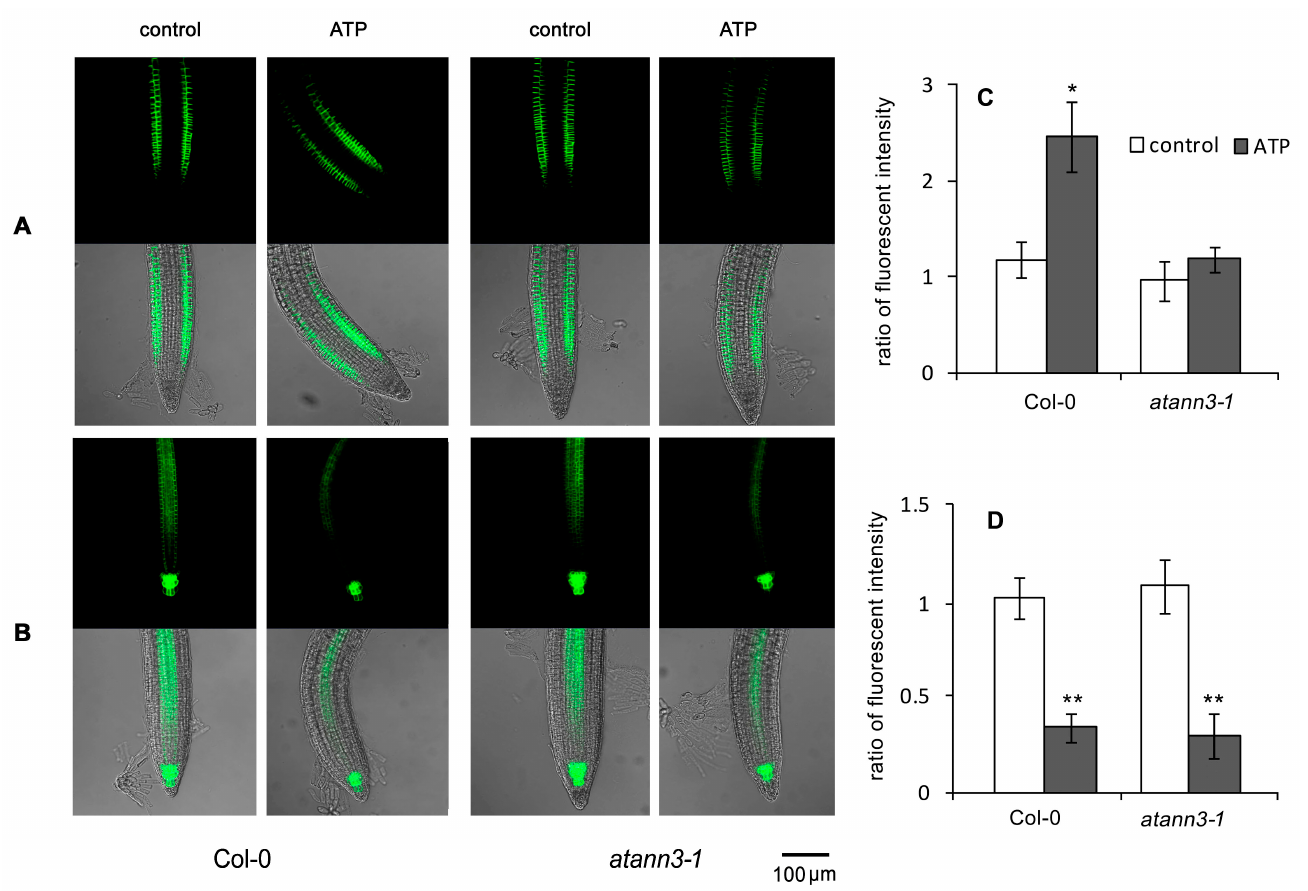
Figure 4. AtANN3 is involved in the eATP-induced PIN2-GFP distribution in root cells. The 4-day-old seedlings of PIN2-GFP or PIN3-GFP transgenic lines were transplanted onto the medium containing 0.5 mM ATP and cultured for 2 more days. ( A , B ) Fluorescent images of PIN2-GFP and PIN3-GFP in root tips, respectively. The scale bar is shown in the lower-right corner of the image. ( C ) The fluorescence intensity ratio of PIN2-GFP in cells at the inner side/outer side at the root curve. ( D ) The fluorescence intensity ratio of PIN3-GFP in QC and stele cells before and after the ATP treatment. The Fluorescence intensity in root tips of untreated Col-0 seedlings was set at 1. In each experiment, at least 15 samples were measured and data from at least three replicates were combined to obtain mean ± SD based on Student’s t -test p -values (* p < 0.05, ** p < 0.01).